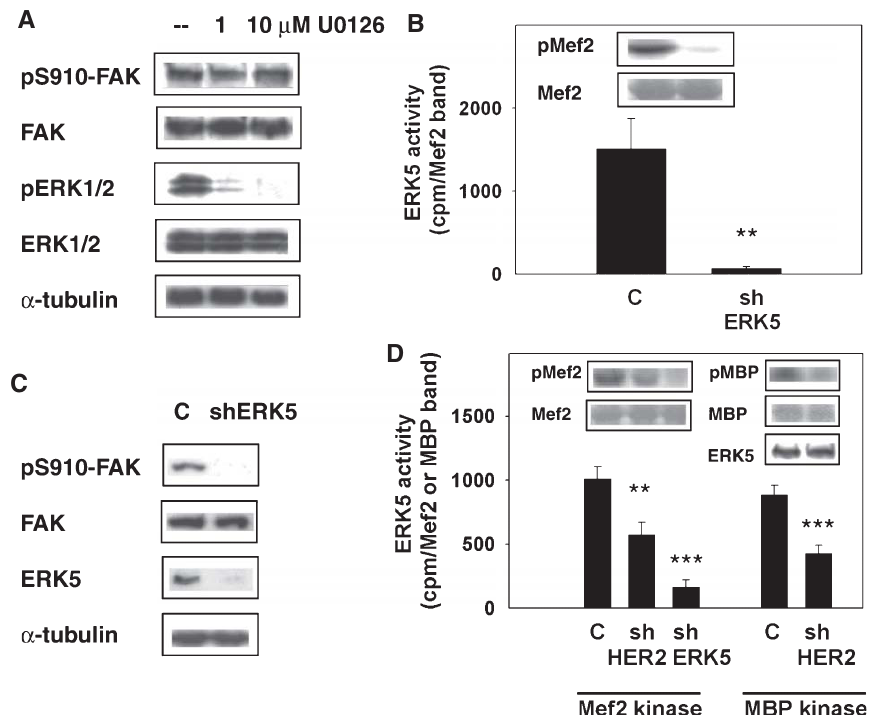
Fig. 5. ERK5 in the HER2-dependent regulation of FAK. (A) Effect of the MEK inhibitor U0126 on FAK and ERK1/2. SKOV-3 cells were treated with the indicated amounts of U0126 for 1h and the lysates obtained were used to immunodetect the phosphorylation of FAK S910 and ERK1/2, FAK, ERK1/2 and (cid:2) -tubulin. The data are representative of 3 independent experiments. (B) ERK5 silencing. Lysates prepared from ERK5-silenced and control cells (carrying the empty vector) were used to assay the ERK5 kinase activity with the ERK5-specific substrate Mef2, as further described in the Methods section. Average ± SEM of 4 experiments. Statistical analysis (Student’s ttest): ∗∗ p <0.01. Inset: Autoradiographic detection of pMef2 phospshorylated with extracts from control and ERK5-silenced cells and Coomasie blue staining of GST-Mef2. The inset shows an example of the autoradiography data used to generate the bar-graph, as further described in the Methods section. (C) Effect of ERK5-silencing on the phosphorylation of FAK at S910. The phosphorylation of FAK S910, FAK, ERK5 and (cid:2) -tubulin were immunodetected in lysates as in B. The results are representative of 3 independent experiments using 2 different ERK5-silenced clones. (D) Effect of HER2-silencing on ERK5 activity. Lysates were obtained from HER2-silenced, ERK5-silenced or control SKOV-3 cells and used to assay ERK5 either as Mef2 kinase (as in B) or as Myelin Basic Protein (MBP) kinase of immunoprecipitated ERK5 (further described in the Methods section). Average ± SEM of 4 experiments. Statistical analysis (Student’s t test): ∗∗ p <0.01; ∗∗∗ p <0.001. Inset. Autoradiographic detection of pMef2 phosphorylated with extracts from control, HER2-silenced and ERK5-silenced cells and Coomasie blue staining of GST- Mef2. Autoradiographic detection of pMBP phospshorylated by ERK5 immunoprecipitated from control and ERK5-silenced cells cell extracts, Coomassie blue staining of MBP and immunoblot detection of ERK5. The insets show examples of the autoradiography data used for the bar-graph.